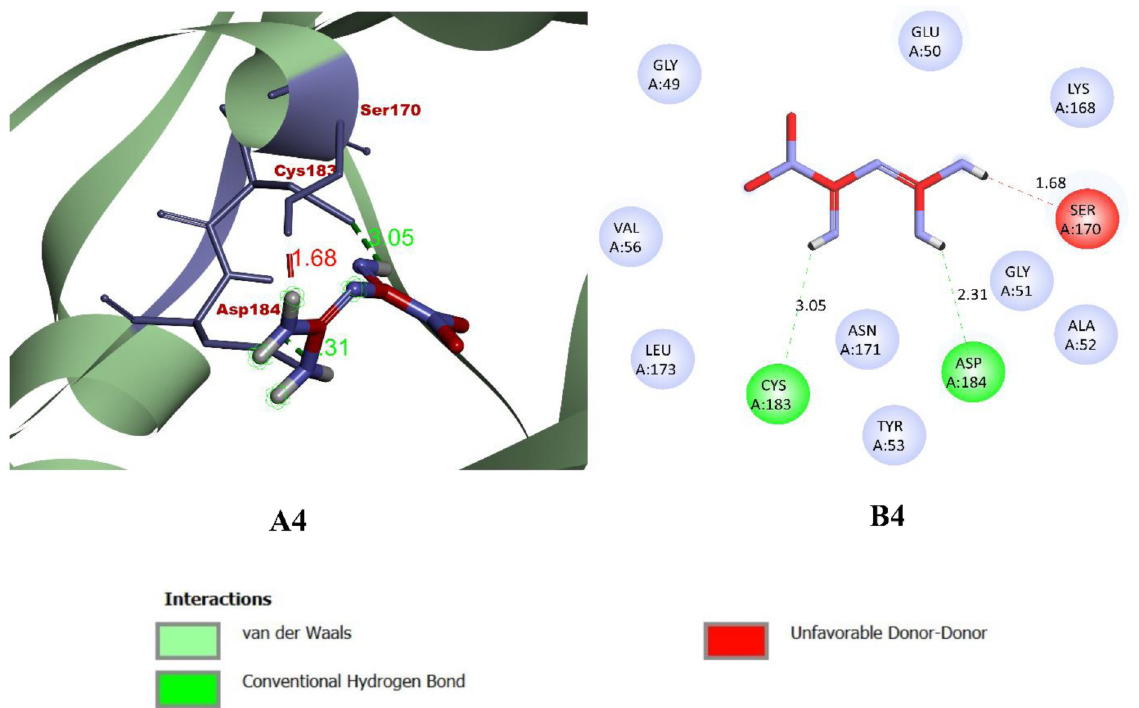
Fig 11. Arrangement (A4) and binding pattern (B4) of binding interactions of metformin from JME with the residues of human MAPK3 protein.